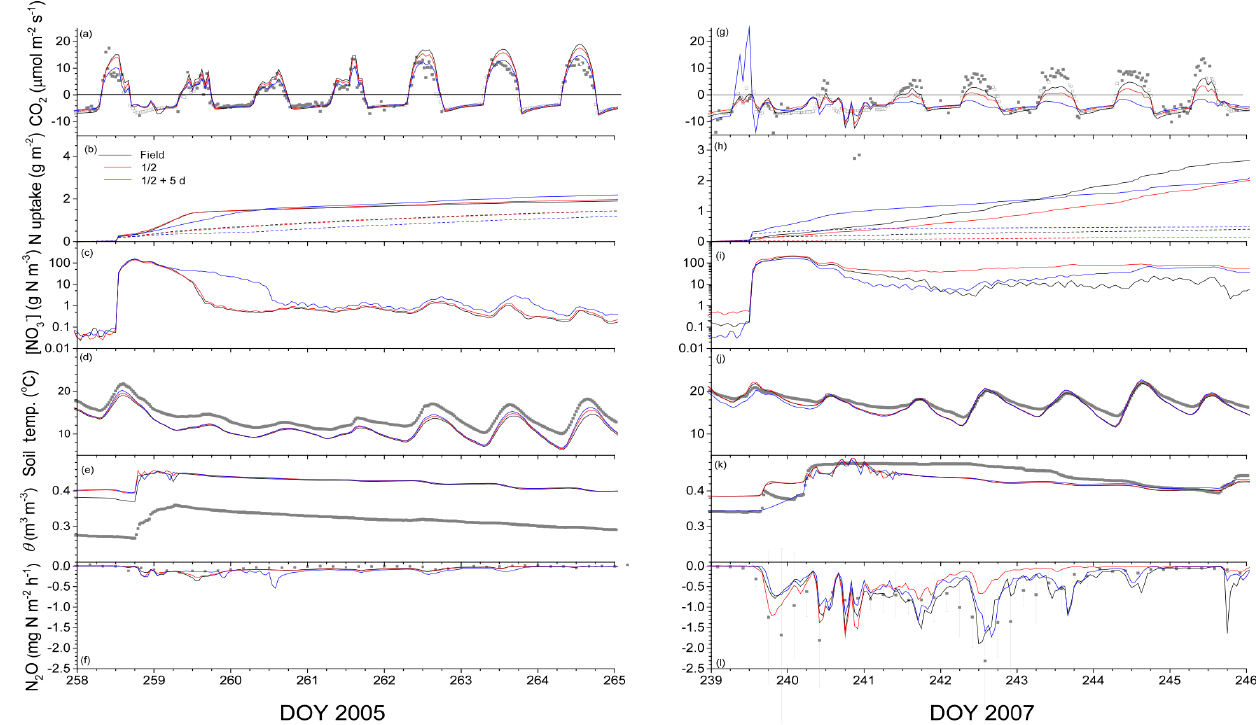
Figure 8. (a, g) CO 2 fluxes, (b, h) cumulative NH + (dashed) and NO − (solid) uptake since fertilizer application, (c, i) aqueous NO − 4 3 concentrations at 0–1cm, (d, j) T s and (e, k) θ at 5cm, and (f, l) N 2 O fluxes measured (symbols) and modelled (lines) with LAI after each cut reduced to half of that estimated from the field experiment without or with a delay of 5 days during emission events following fertilizer applications on DOY 259 in 2005 (a–f) and DOY 240 in 2007 (g–l) (see Table 2). For fluxes, positive values represent influxes to the soil, negative values effluxes to the